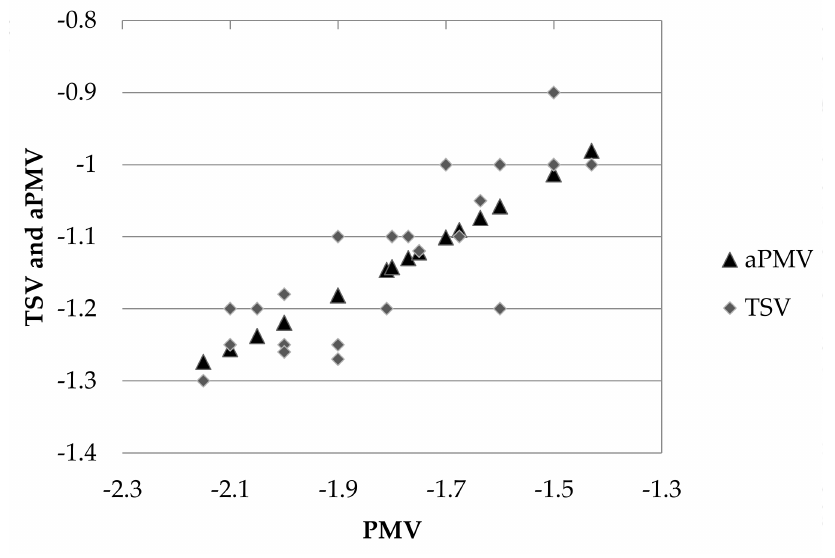
Figure 13. Correlation between aPMV and